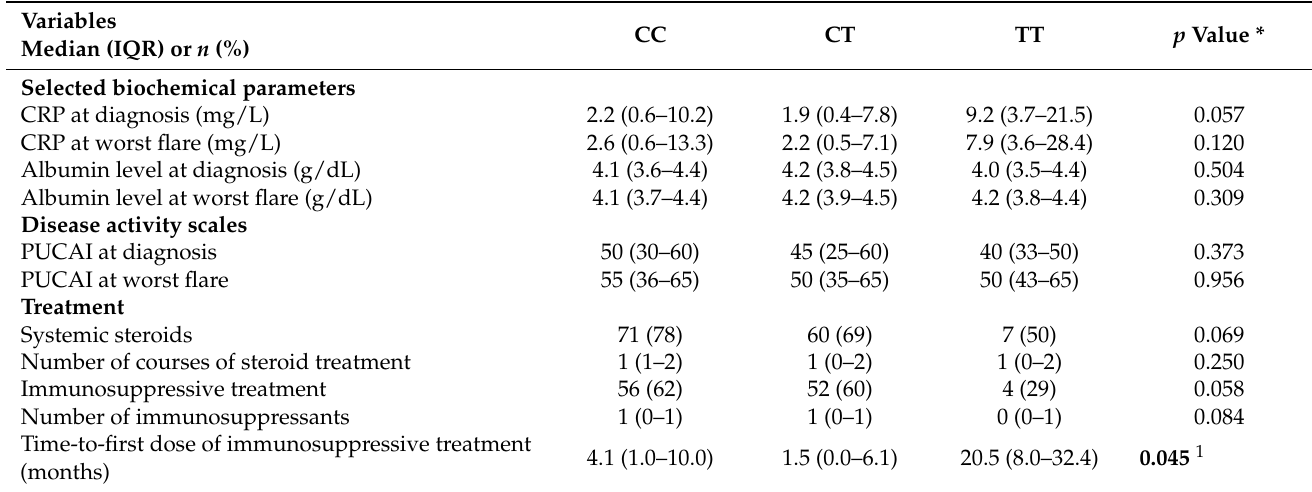
Table 5. Association between DMBT1 rs2981745 genotypes and UC